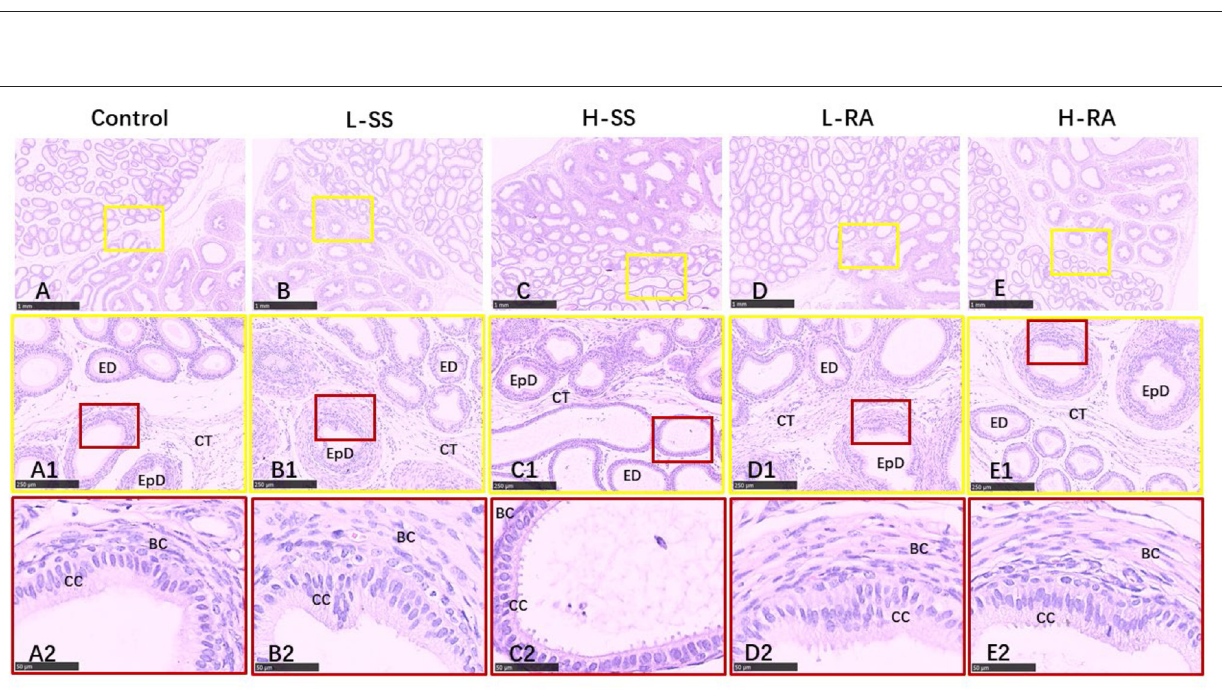
Frontiers in Nutrition |